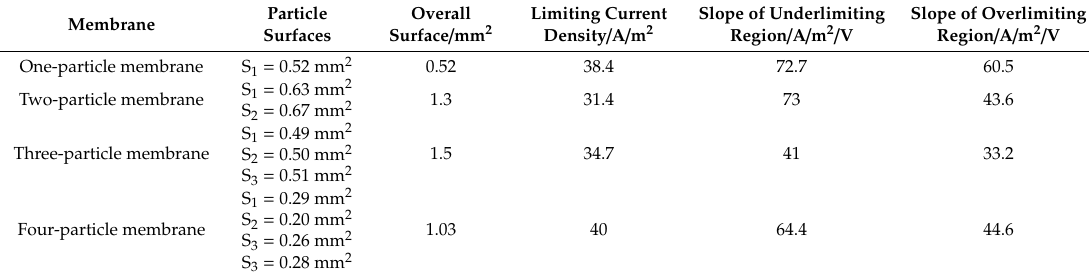
Figure 6. Current–voltage curves of the studied systems. The red curve represents the one-particle systems, the black one the two-particle system, the green one the three-particle system, and the blue one the four-particle system. We evaluated the slope of the underlimiting and overlimiting regions and the limiting current density, which are given in Table 1. Table 1. Characteristics of the individual studied systems and their ion-exchange